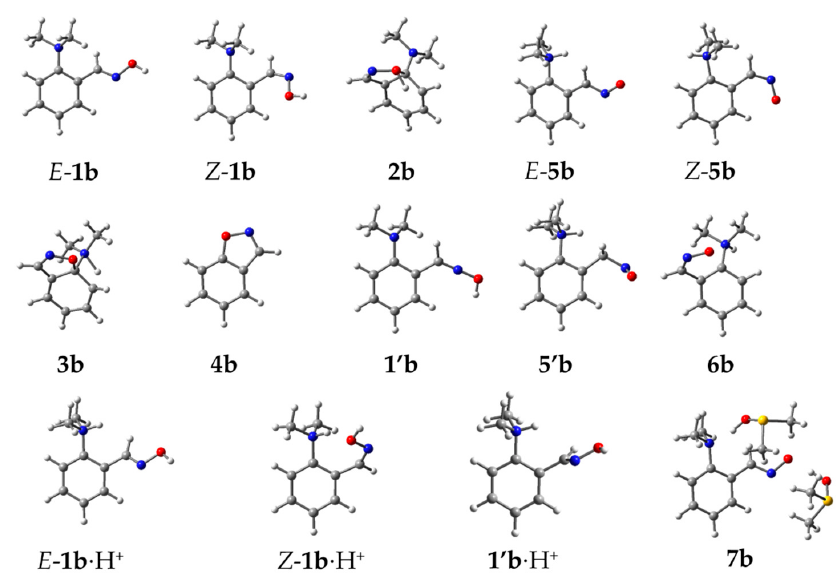
→ 4b transformation.